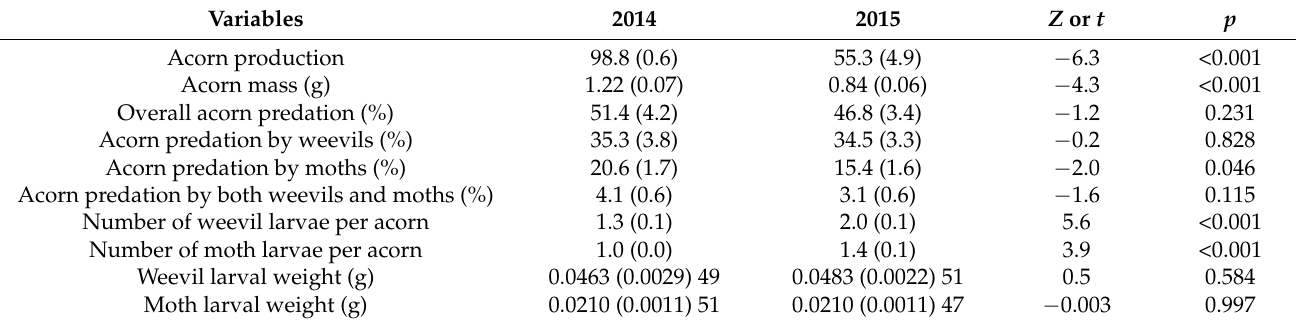
Table 1. Crop size and acorn mass for Valencian oak trees, and seed predation rates, number of larvae per acorn and larval weight for two pre-dispersal insect predators in two years with contrasting acorn production in a population in central Spain. Values are mean (SE), and Z or t statistics and associated p -values from mixed or linear models comparing between-year differences for each variable. Sample size was 59 and 51 trees in 2014 and 2015, respectively, except for variables on larval weight, in which the number of trees is indicated after their